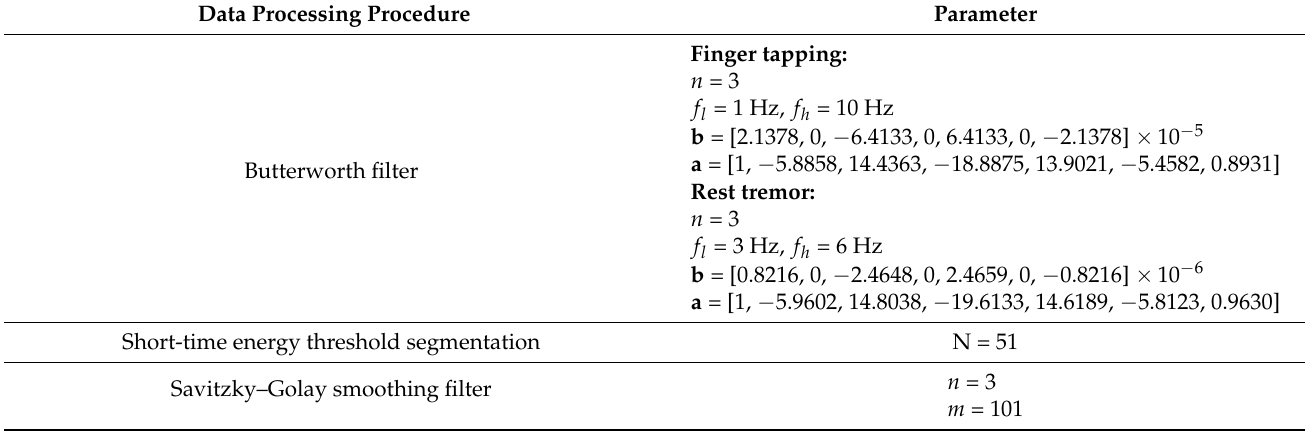
Table 1. Parameters used in the CSI data processing procedures for quantifying